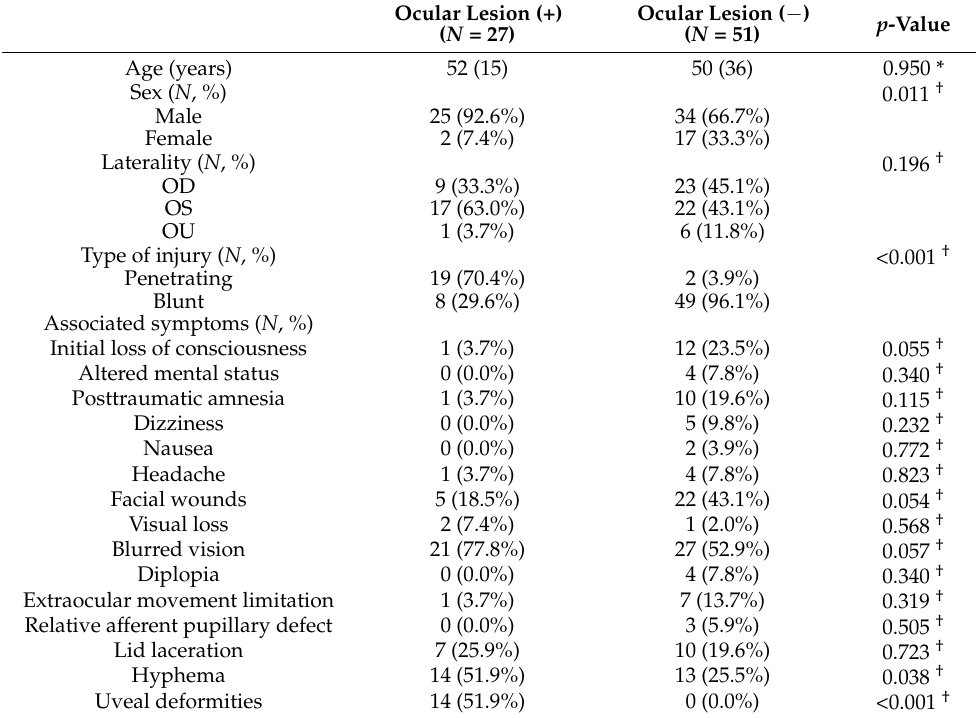
Table 3. Characteristics of head injury patients who underwent an ophthalmology consultation in the emergency department and without ocular lesions on CT scans ( N = 78).